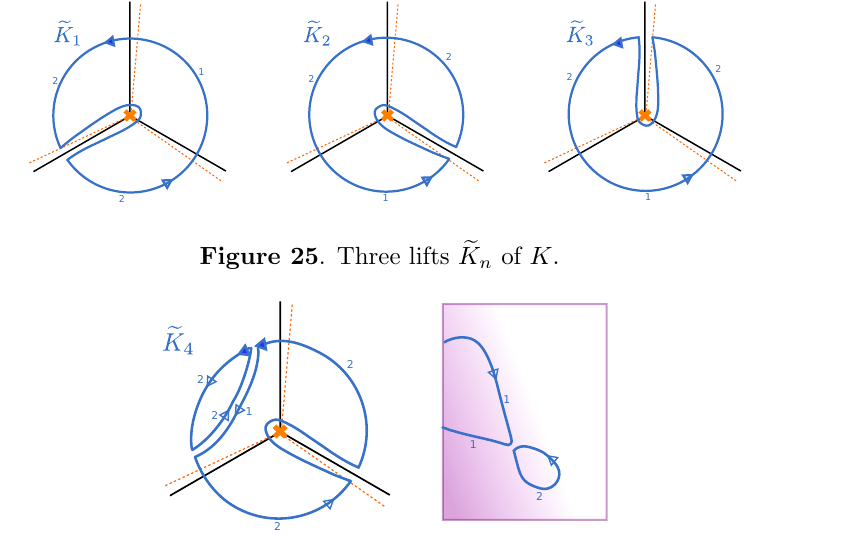
Figure 26 . A lift e K 4 of K . Left: the standard projection. Right: the part of the leaf space projection involving the